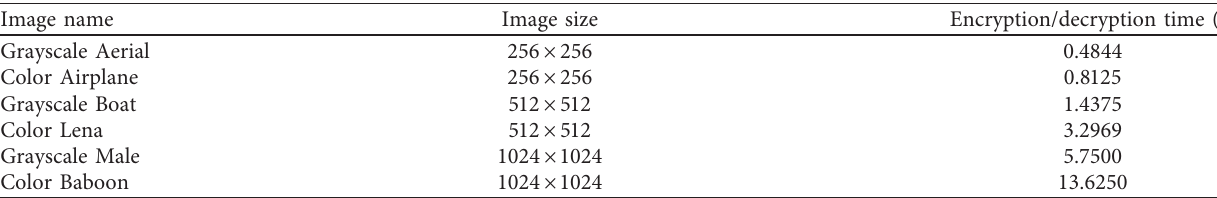
Figure 13: Simulation result of cryptanalysis tests: (a) all white image; (b) cipher image of (a); (c) histogram of (b); (d) all black image; (e) cipher image of (d); (f) histogram of (e). Table 10: Running time analysis.